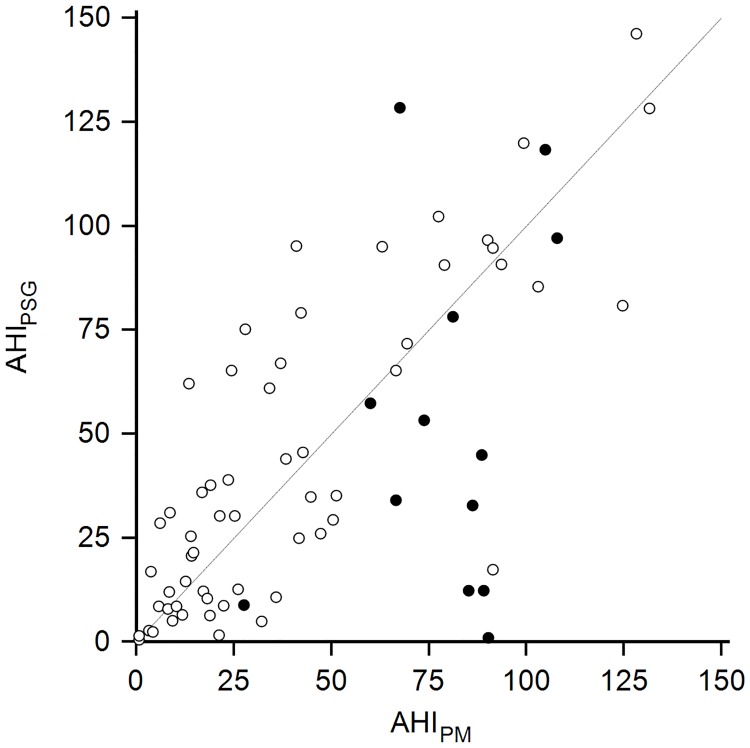
Scatterplot for AHIPM and AHIPSG.The line represents perfect agreement. The black circles represent patients with central apnea index on portable monitoring ≥ 5.